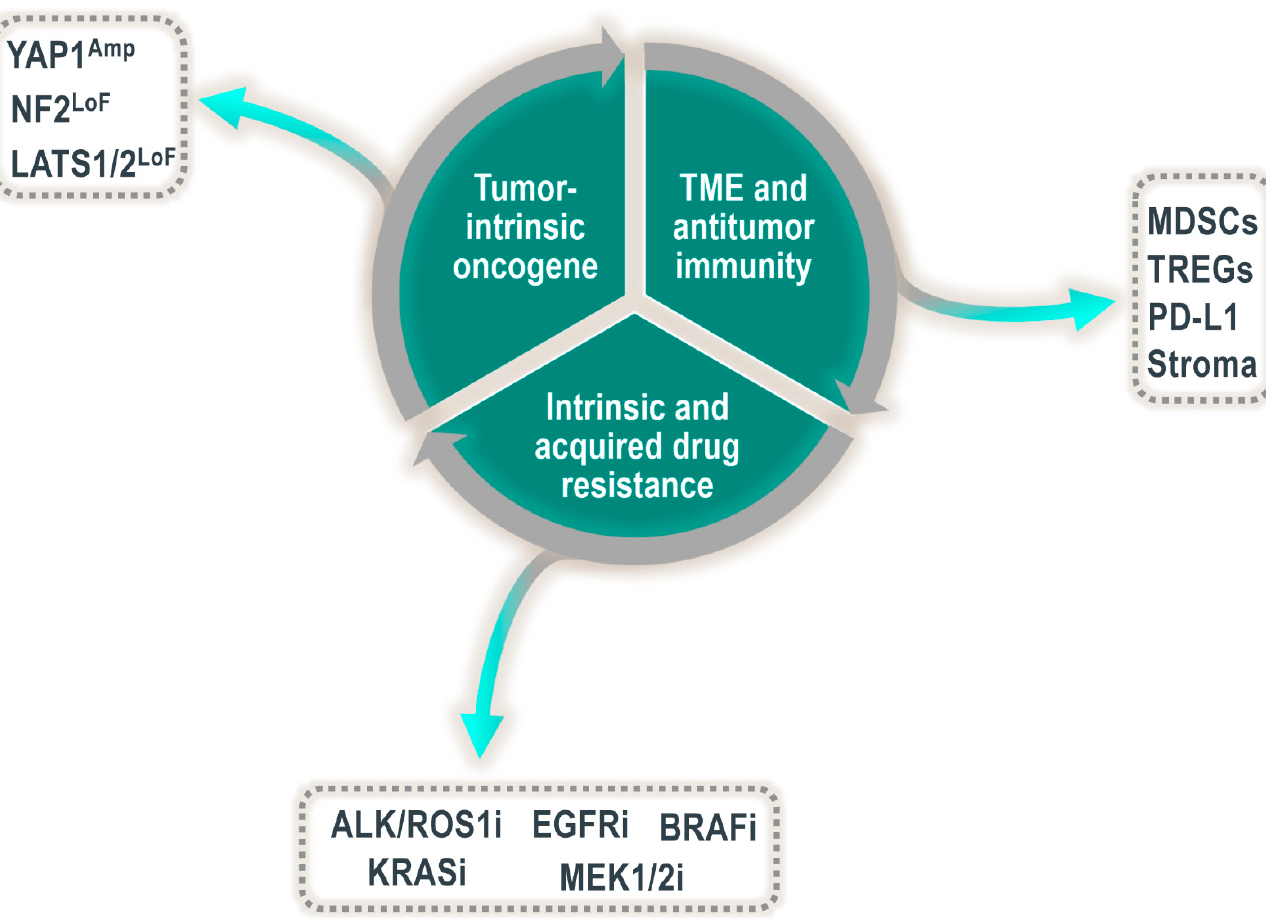
Figure 2. Multifaceted role of YAP1/TEAD in driving tumor growth and/or progression. Amp = amplification; LoF = loss of function; ALK/ROS1i, EGFRi, BRAFi, KRASi, MEK1/2i = inhibitors of ALK/ROS, EGFR, BRAF, KRAS and MEK .